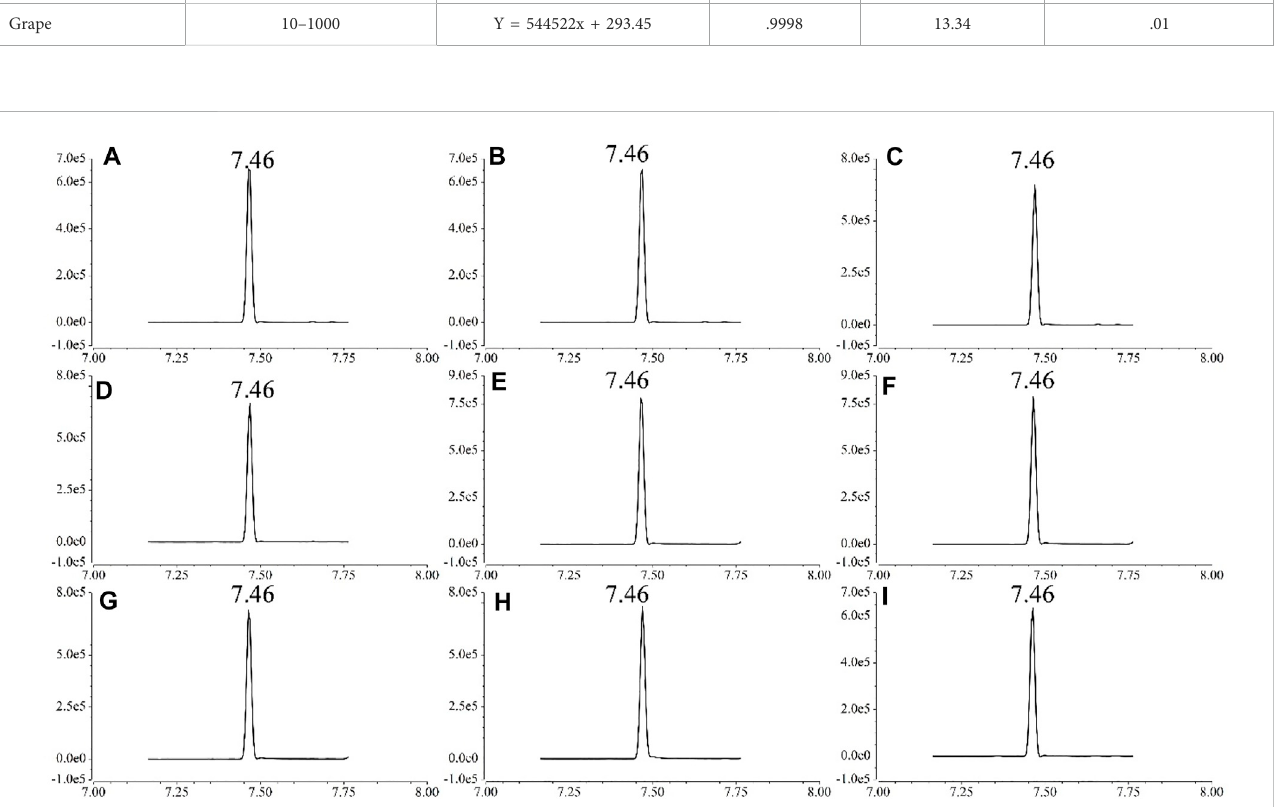
TABLE 3 Linear equation, ME, and LOQ of fl uopyram in nine foodstuff matrices by GC-MS/MS. Matrix Range ( μ g/kg) Linear equation R 2